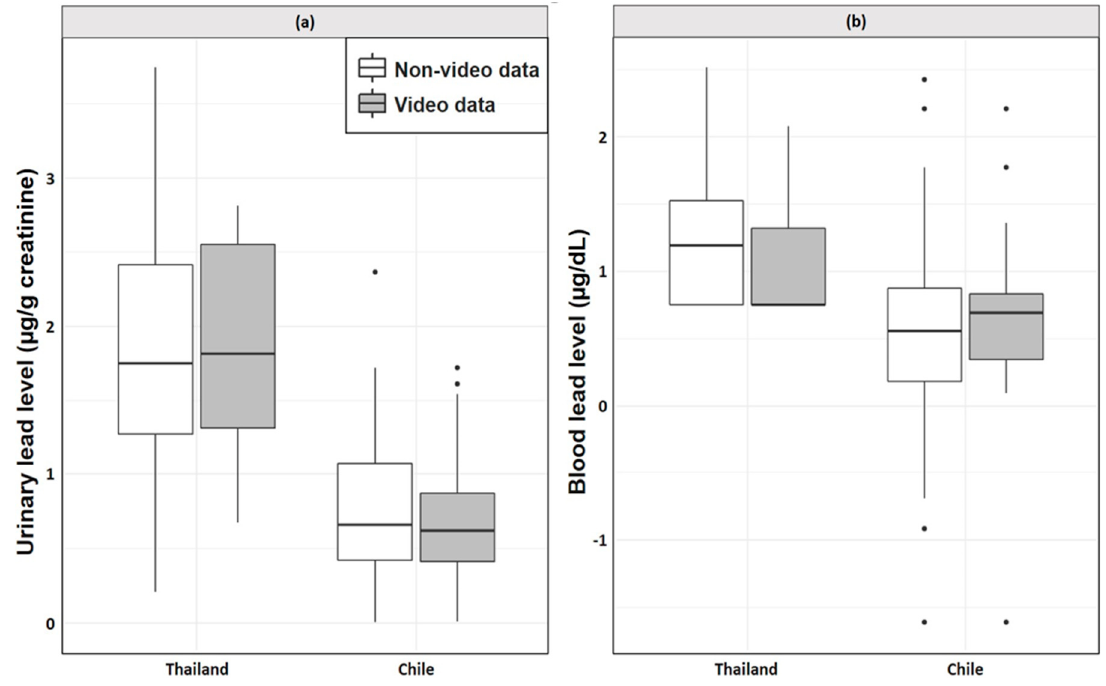
Figure 2. Boxplots of log lead concentrations in ( a ) urine ( µ g/g creatinine) and ( b ) blood ( µ g/dL) among video and non-video electronic waste participants in both Thailand and Chile.